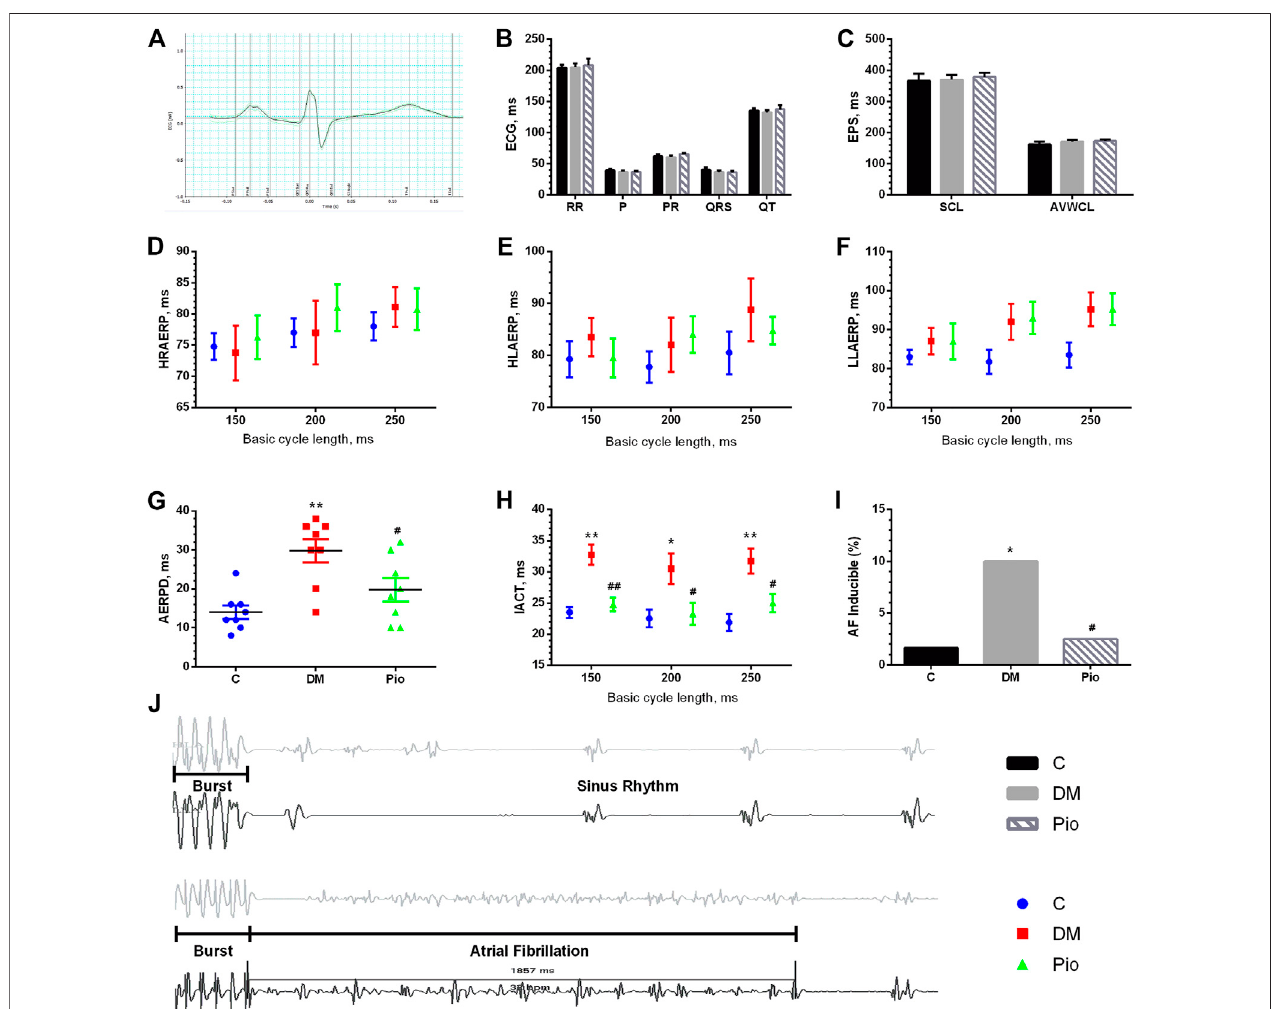
FIGURE 2 | Pioglitazone inhibited diabetes-induced electrical remodeling and prevented the development of AF. An example electrocardiogram trace (A) and quanti fi cation ofECG parameters (RR interval, P-wave duration,PRinterval, QRSduration, andQTintervals) (B) . (C) Parameters from EPS [sinuscycle length(SCL)and AV Wenckebach cycle length (AVWCL)]. (D – F) Quanti fi cations of high right atrium effective refractory period (HRAERP), high left atrium effective refractory period (HLAERP), and low left atrium effective refractory period (LLAERP) at basic cycle lengths (BCLs) of 150, 200, and 250 ms. (G) Quanti fi cation of atrial effective refractory period dispersion (AERPD). (H) Interatrial conduction time at BCLs of 150, 200, and 250 ms. (I) Quanti fi cation of the inducibility of AF. (J) Representative AF episode and control sinus rhythm data induced by burst pacing. Values are presented as mean ± SEM. *Compared with the C group, p < 0.05; **compared with the